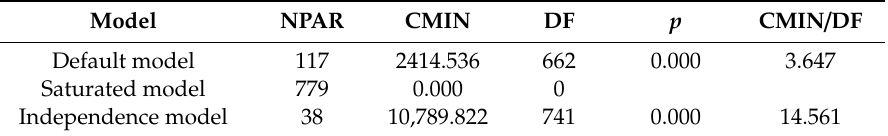
Table 4. NPAR, CMIN, DF, P and CMIN/DF.